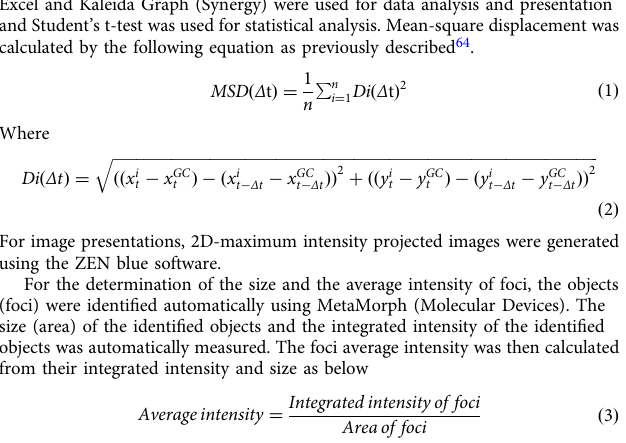
Fig. 8 RAD23B mediates SIPAN formation. a Analysis of domains and intrinsically disordered regions of RAD23 proteins. Prediction of order/disorder propensity of human RAD23B (left panel, uniprot #P54727) and yeast RAD23 (right panel, uniprot #P32628) based on their protein sequences. Disorder scores were calculated using PONDR-FIT (green), VSL2B (blue), and VLXT (magenta). b , c RAD23B lacking critical domains failed to assemble in SIPAN.